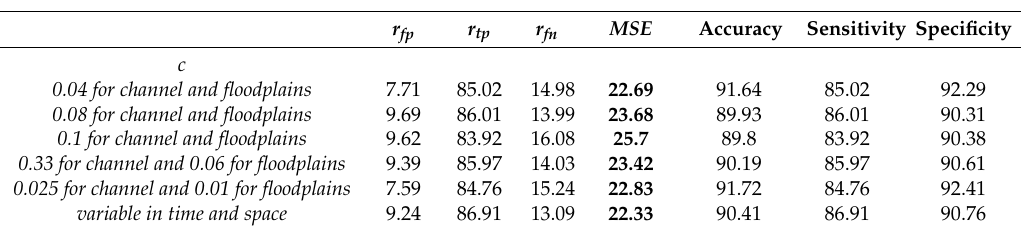
Table 2. Results of the calibration performance of the hydraulic simulation model for 3 November 2010 in terms of a flood extent map: the set of Manning coefficients c , false positive rate r fp , true positive rate r tp , false negative rate r fn , minimized sum of errors ( MSE ), and accuracy, sensitivity, and specificity.